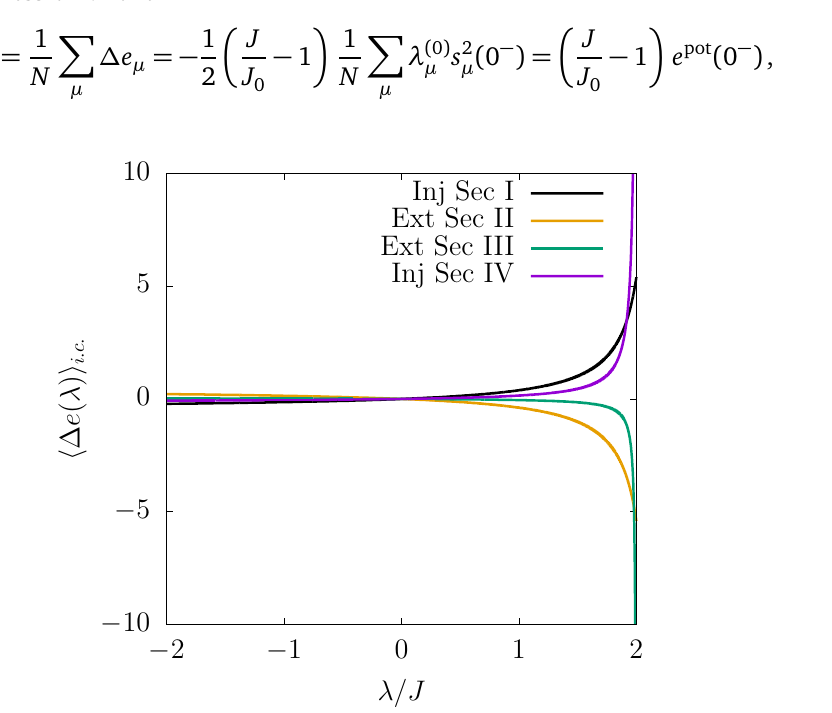
Figure 2: Averaged mode energy variation at the instantaneous quench in the = 1.5 > J N → ∞ limit. The parameters are T , J = 0.4 < J in phase I (injection), 0 0 0 = 1.5 > J = 0.5 < J T , J = 1.6 > J in phase II (extraction), T , J = 1.2 > J 0 0 0 0 0 = 0.5 < J in phase III (extraction), and T , J = 0.4, J in phase IV (injection). 0 0 0 〉 In phases I and II 〈 ∆ e is finite while in phases III (green) and IV (violet) it is N i . c . proportional to N